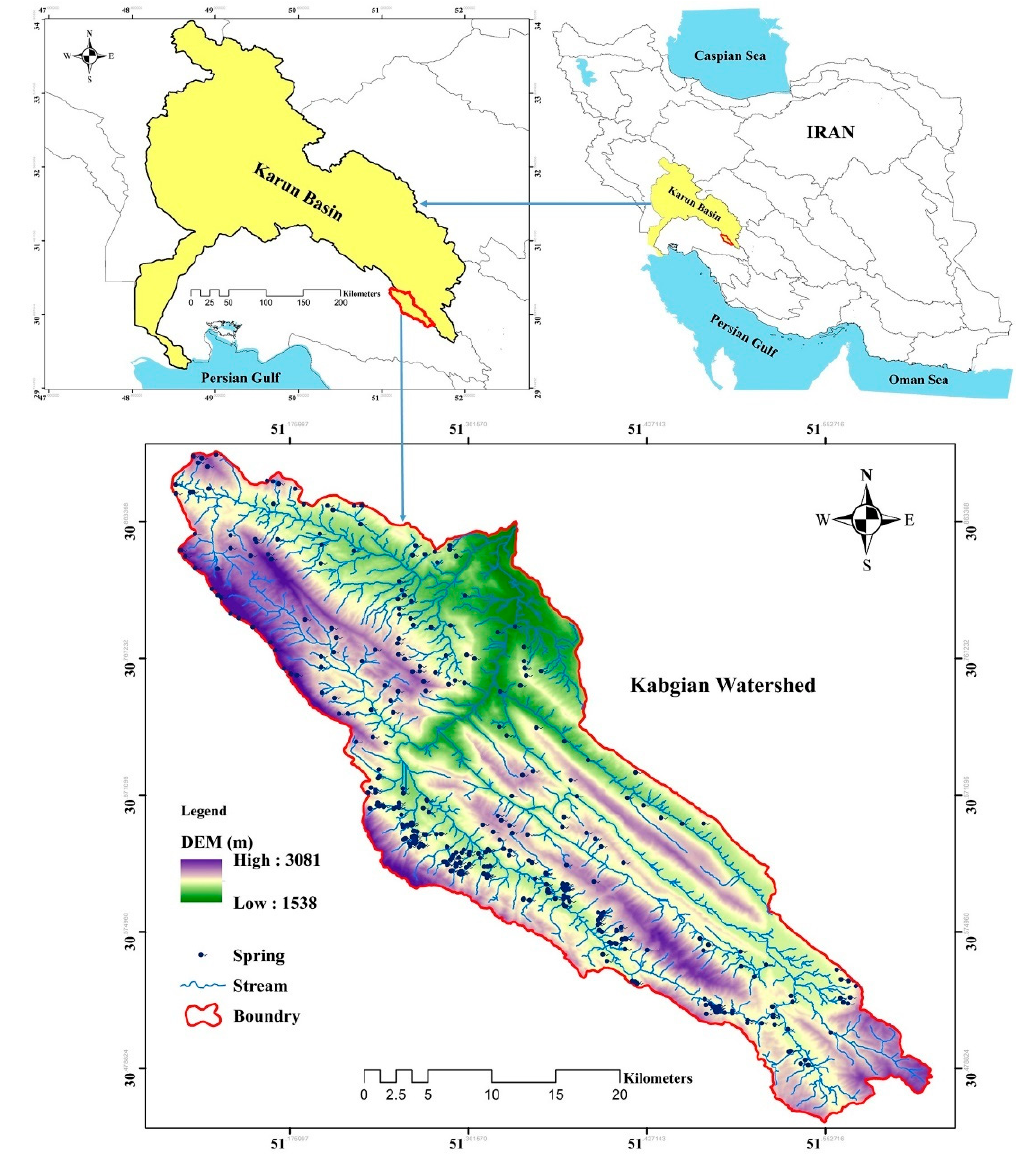
Figure 1. Location of the Kabgian watershed in Iran. Table 1. Lithological characteristics of the Kabgian watershed.